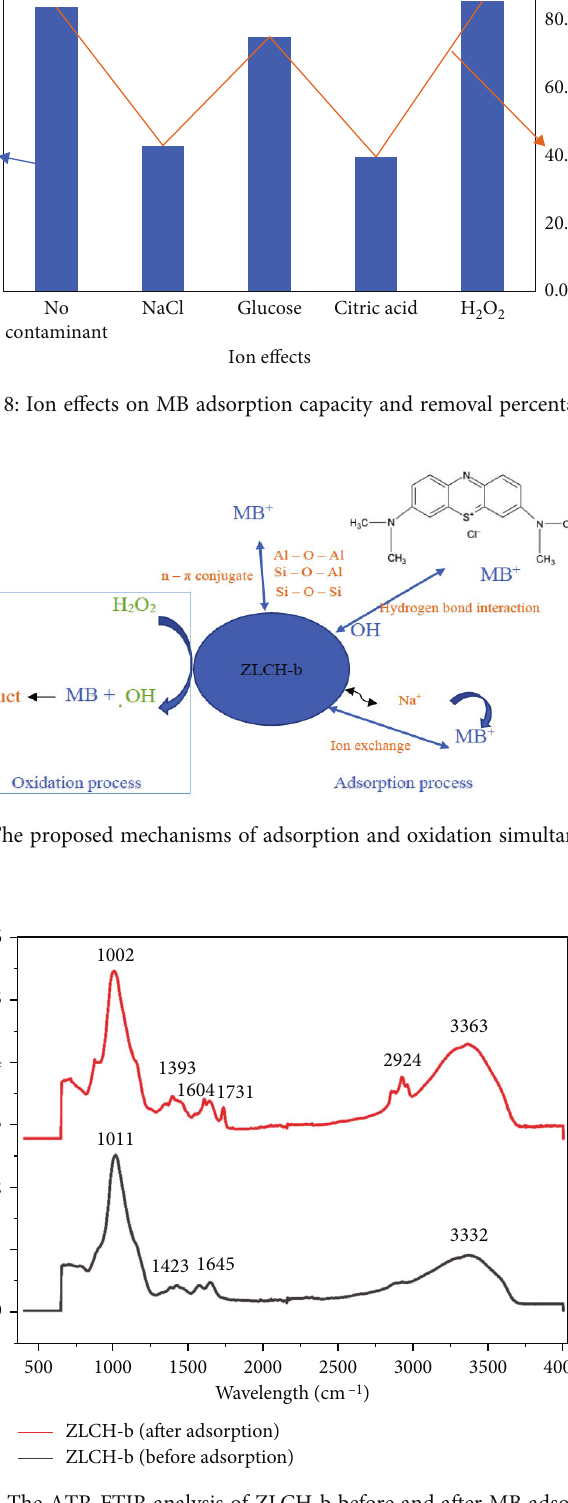
Figure 10: The ATR-FTIR analysis of ZLCH-b before and after MB